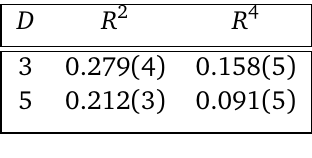
Table 3: The results obtained for D = 3,5 matrices models with mass terms are given for λ = 4, h = 1 with N =